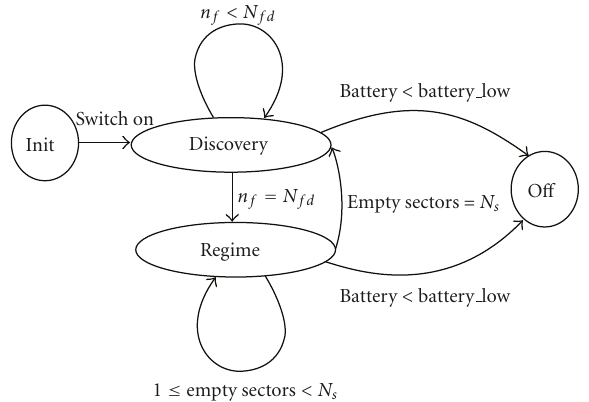
Figure 1: Finite state machine description of the proposed D-STAR protocols, involving the transitions occurring among init , discovery , regime , and o ff